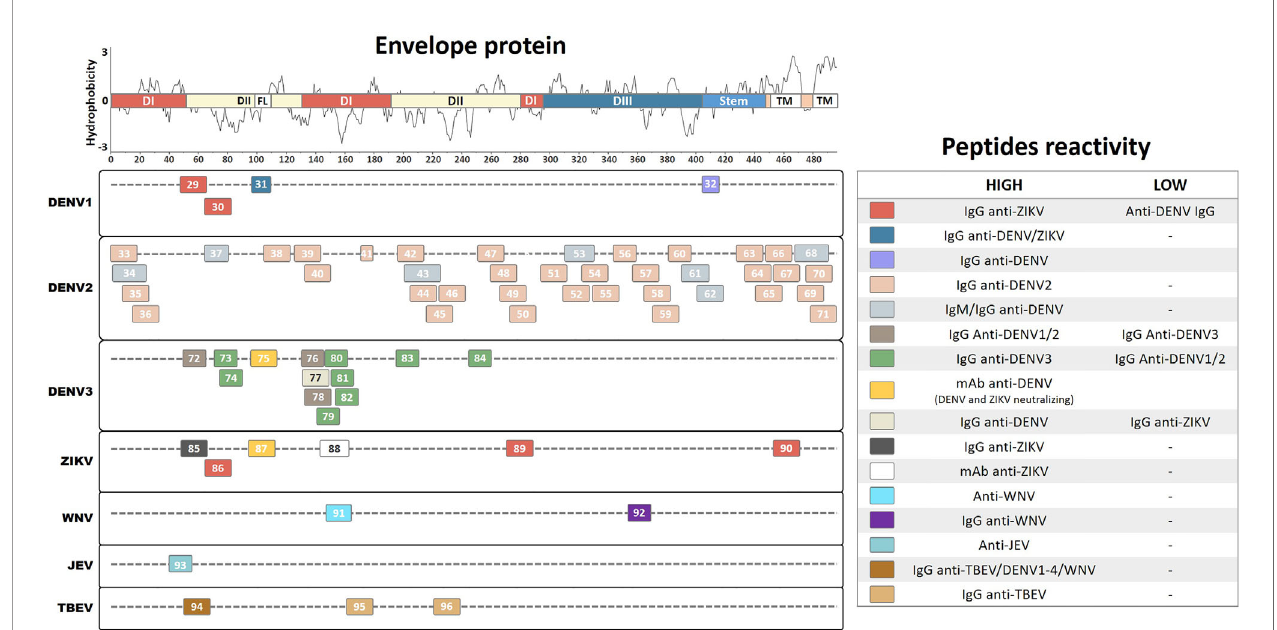
FIGURE 3 | Linear representation of Flavivirus envelope protein. The representative topology and domain demarcation were determined based on the ZIKV entry query of Uniprot Q32ZE1. Linear peptides are labeled by numbers and the antibody reactivity indicated by colors. The hydrophobicity prediction pro fi le was determined using the amino acid sequence of the ZIKV (Genbank YP_002790881) with the Kyte & Doolittle hydropathy score scale (J. Mol. Biol. 157:105-132(1982). DI/II/III, Domains I, II and III; FL, Fusion-loop; TM, Transmembrane